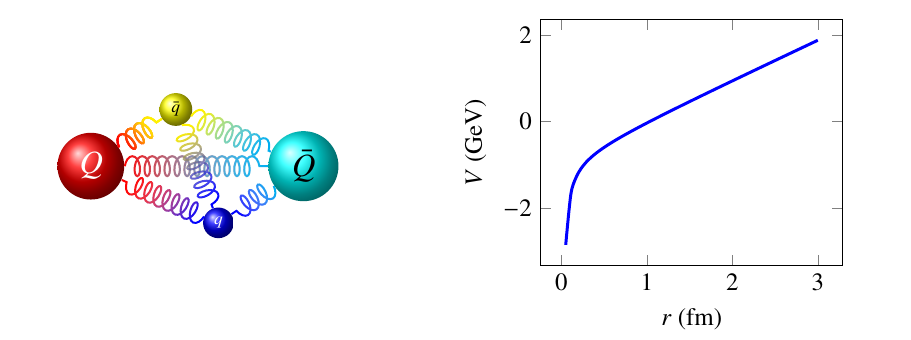
Figure 1. Left: pictorial representation of a quarkoniumlike meson as a heavy quark-antiquark pair ( Q ¯ Q ) interacting with sea quarks (represented by a single light quark pair q ¯ q ) and gluons (represented by the colored coils connecting the quarks). Right: phenomenological funnel potential, representing the lowest static energy between a quark-antiquark pair interacting with gluons only (no sea quarks).